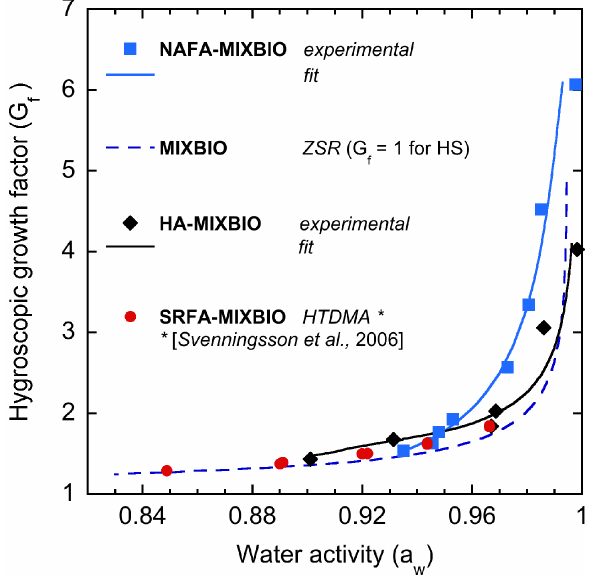
Fig. 9. Hygroscopic growth factor as a function of water activity for NAFA and HA in MIXBIO at 25 ◦ C. Solid symbols show growth factors calculated from bulk solution measurements using Eq. (3). Solid lines represent the fit to the data based on the water activ- ity parameterizations presented in Table 1. Red solid circles show HTDMA data at 21–24 ◦ C for Suwannee River fulvic acid (SRFA) in MIXBIO from published work by Svenningsson et al. (2004). The dashed line denotes the prediction by the ZSR approach for MIXORG containing NAFA, HA or SRFA, based on no hygro- scopic growth observed for these HS below a w of 0.999 in Zamora et al.